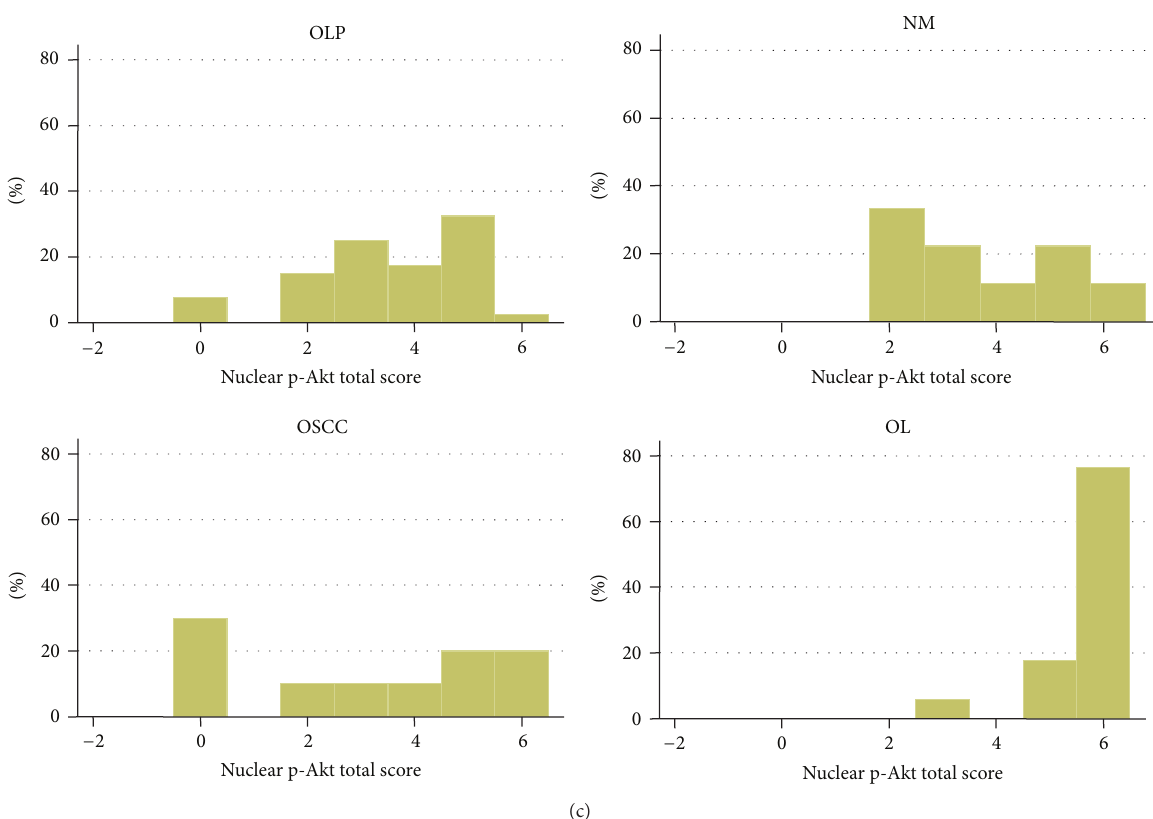
Figure 2: Graph of immunohistochemical results for nuclear p-Akt. Distribution of cases per lesion category according to (a) positivity score, (b) intensity score, and (c) total score. Abbreviations: OLP: oral lichen planus; NM: normal mucosa; OSCC: oral squamous cell carcinoma; OL: oral leukoplakia. Table 2: Percentage of positive cases and average positivity, intensity, and total scores for cytoplasmic p-Akt per lesion category. Number and % of positive